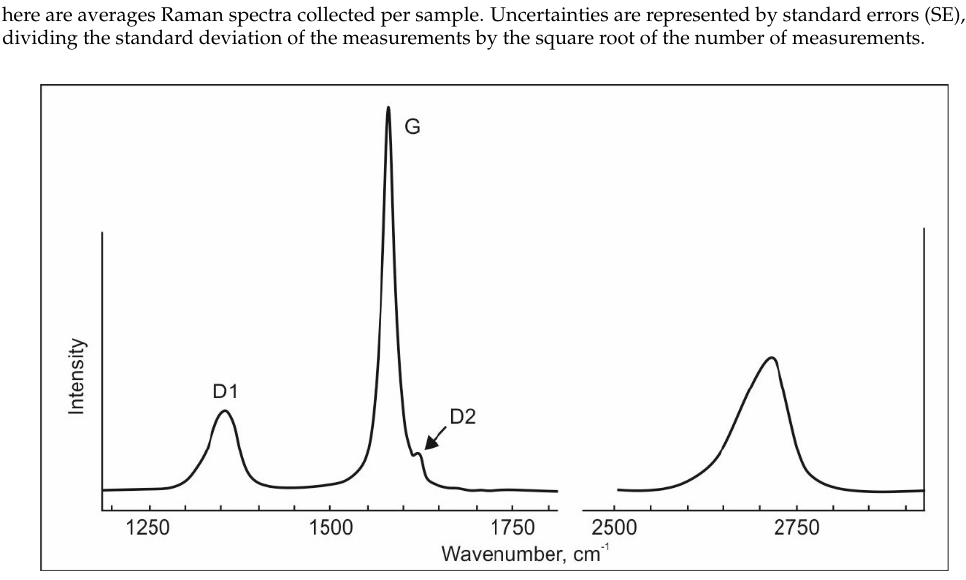
Figure 8. Distribution histograms of temperatures estimated with carbonaceous material thermom- etry [3]. Black peaks show distribution of temperatures obtained with Grt-Bt thermometry for the same samples (uncertainty of geothemometer is not considered). ( a – c )—Olympiada deposit: ( a )—